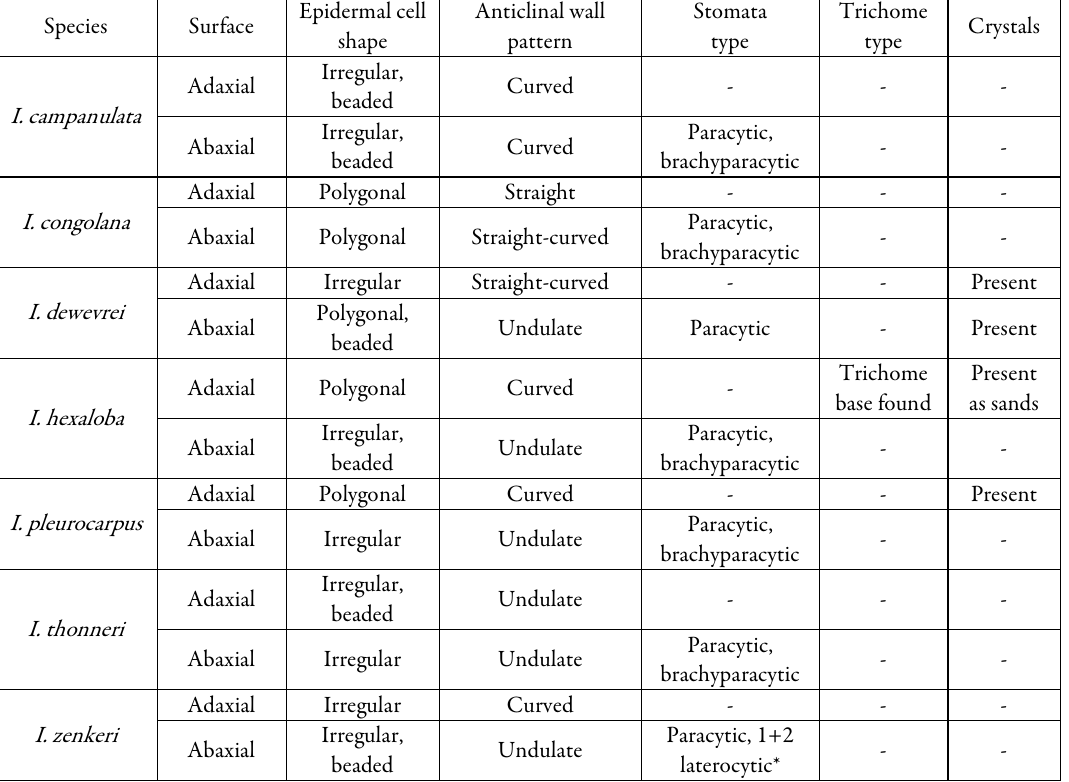
*= stomatal type in the sense of Carpenter